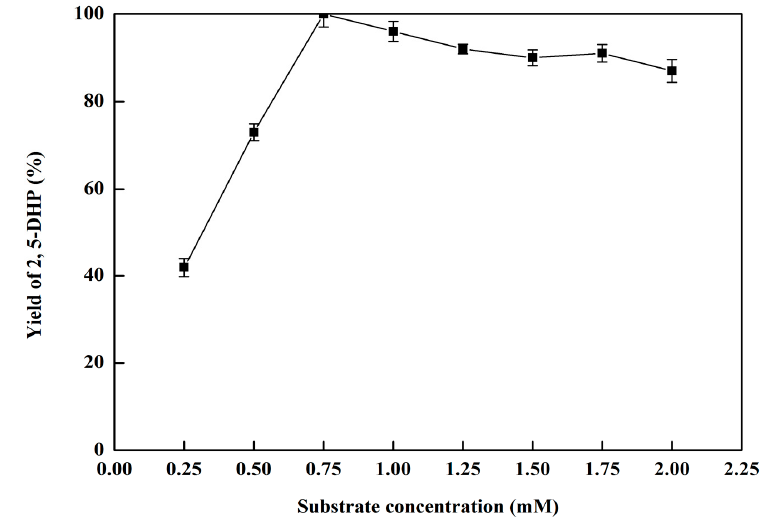
Figure 6. Effect of substrate concentration on the production of 2,5-DHP for HSPH ZZ and ImmHSPH ZZ .